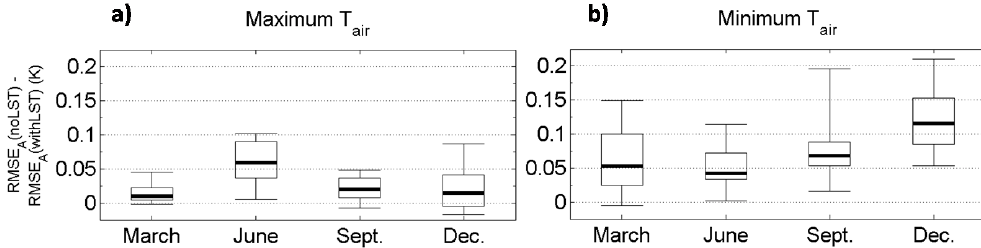
Figure 9. Idem to Figure 6a,b, but corresponding to the differences between performance metrics achieved by models without LST and models with LST.